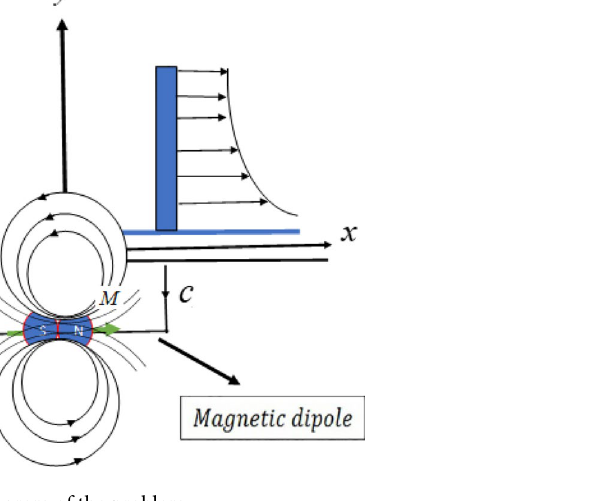
Figure 1. Schematic diagram of the